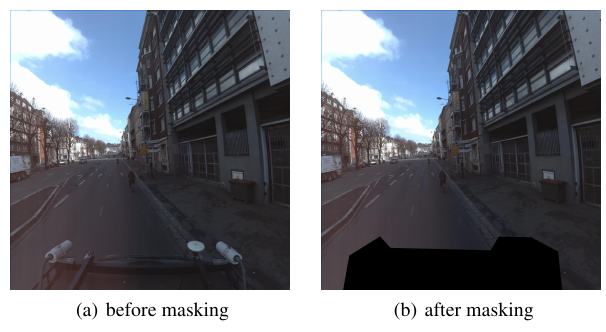
Figure 5. Illustration of the acquired frontal images